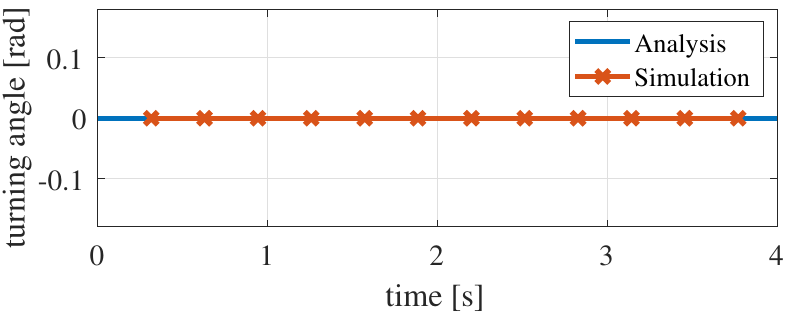
Figure 6. The time variation of the turning angle in the simulation for forward locomotion. Since the turning angle indicates 0 rad, the simulation results show that the robot moves forward by setting β =